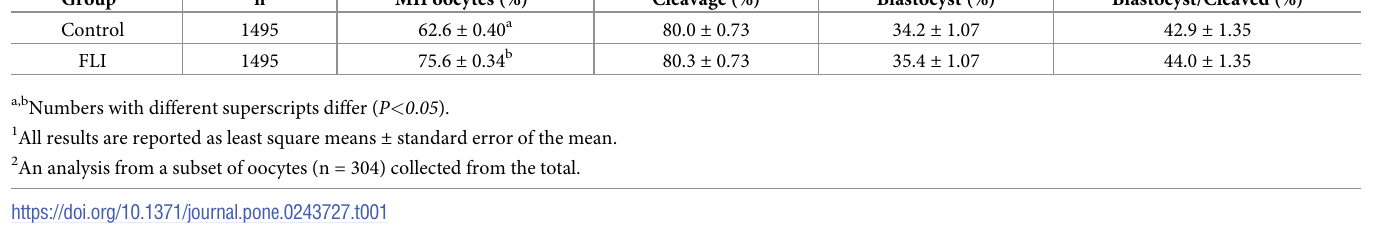
Fig 5. FLI supplementation advances transzonal projection dissociation. (A) The effect of the addition of FLI to oocyte maturation medium on the number of TZP at 6, 12, 18, and 24hr. (n = 198; 100 control and 98 +FLI). (B) The images are representative of TZP dissociation at 24hr of maturation. Arrows indicate intact TZP. Asterisk ( � ) indicates statistical differences ( P < 0.05).